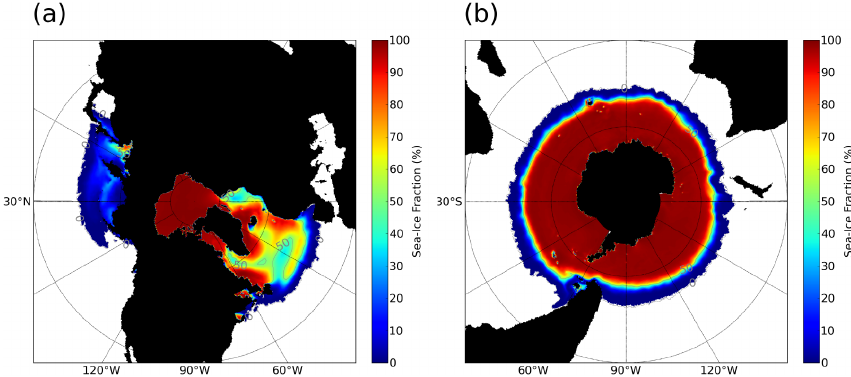
Fig. 4. Polar stereographic map of the boreal summer (JAS) sea-ice fraction (a) in the Northern Hemisphere and (b) in the Southern Hemi- sphere as simulated by the eddy-permitting model. Units in %.